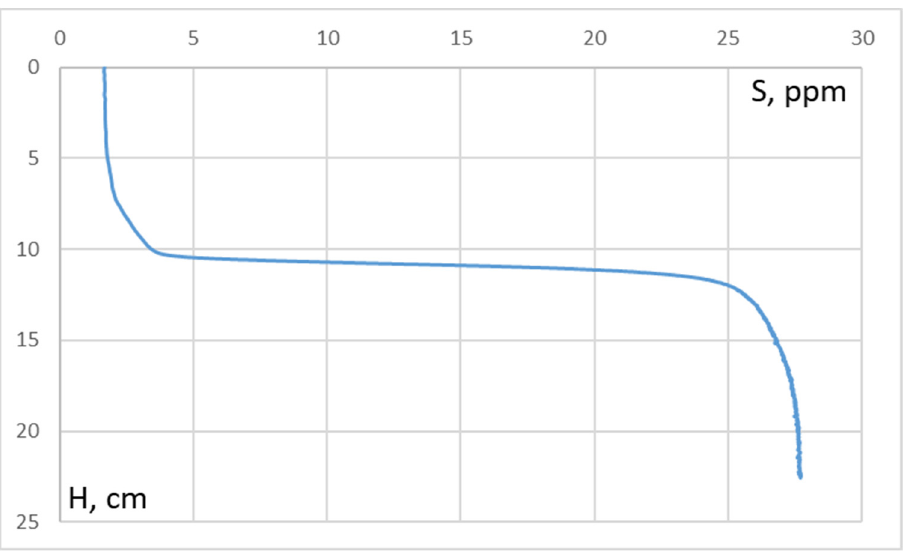
Figure 12. The snapshot of the salinity profile measured by the conductivity microsensor at a moment of time during the density interface sharpening ( Ri initial = 100; Re = 214